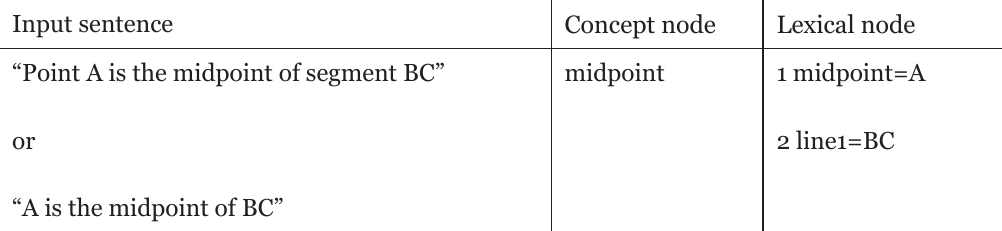
Result of Concept Matching for